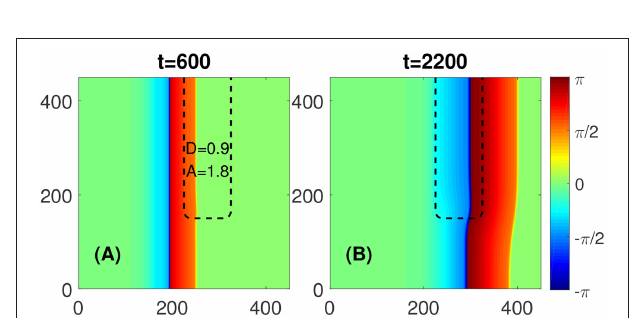
FIGURE 3 | No blockage occurs at the flat boundary of a FPR if D and/or A inside it are below some critical values. (A) No PCP would emerge for FIGURE 1 | Rotor initiated due to a rectangularly shaped fast propagation region (FPR). (A) The FPR marked by a black dashed line has length L 300 = and two rounded corners with the radius of R 15. Within the FPR D 1, = = A 2 and outside the FPR D 1 and A 1. A plane wave propagates from = = = the left toward the FPR. (B) The wave is blocked at the flat boundary of the FPR but penetrates into it at the rounded corner. (C–E) A rotor is initiated and stably rotates. The white dot and line are the rotors phase change point (PCP) and its trajectory, respectively.